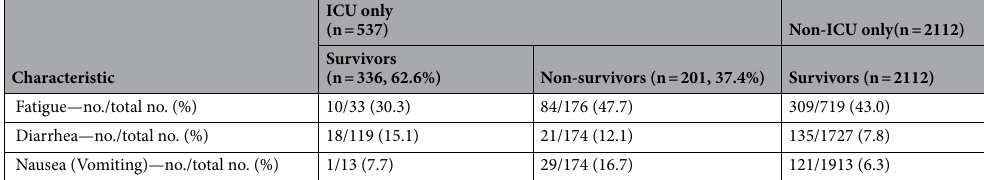
Table 3. Characteristics, blood parameters, symptoms, and pre-existing conditions among ICU and non-ICU patients infected with COVID-19. CI confidence interval, NR not reported, NA not applicable.